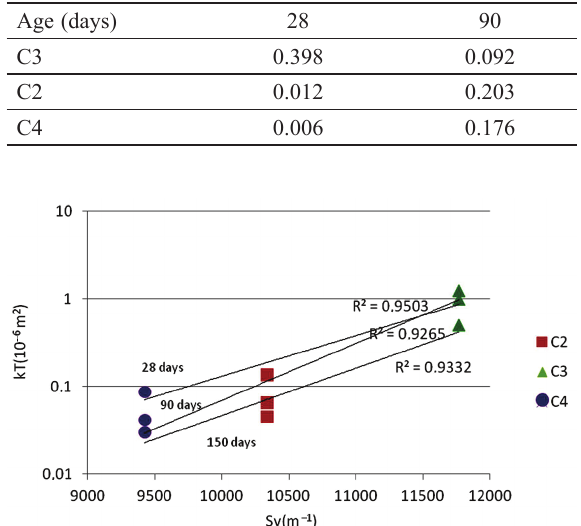
Fig. 11. Air permeability (logarithmic scale) vs. surface density of the aggregate ( Sv )